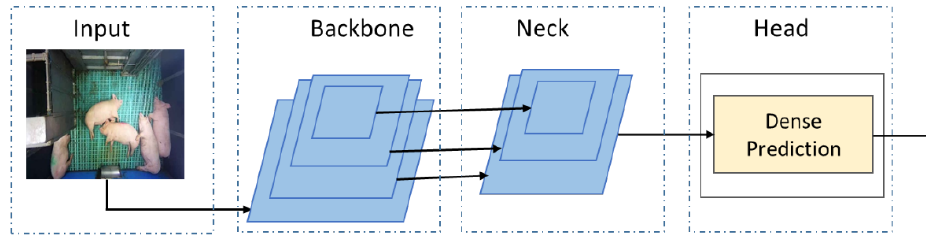
Figure 3. YOLOv4 network architecture.